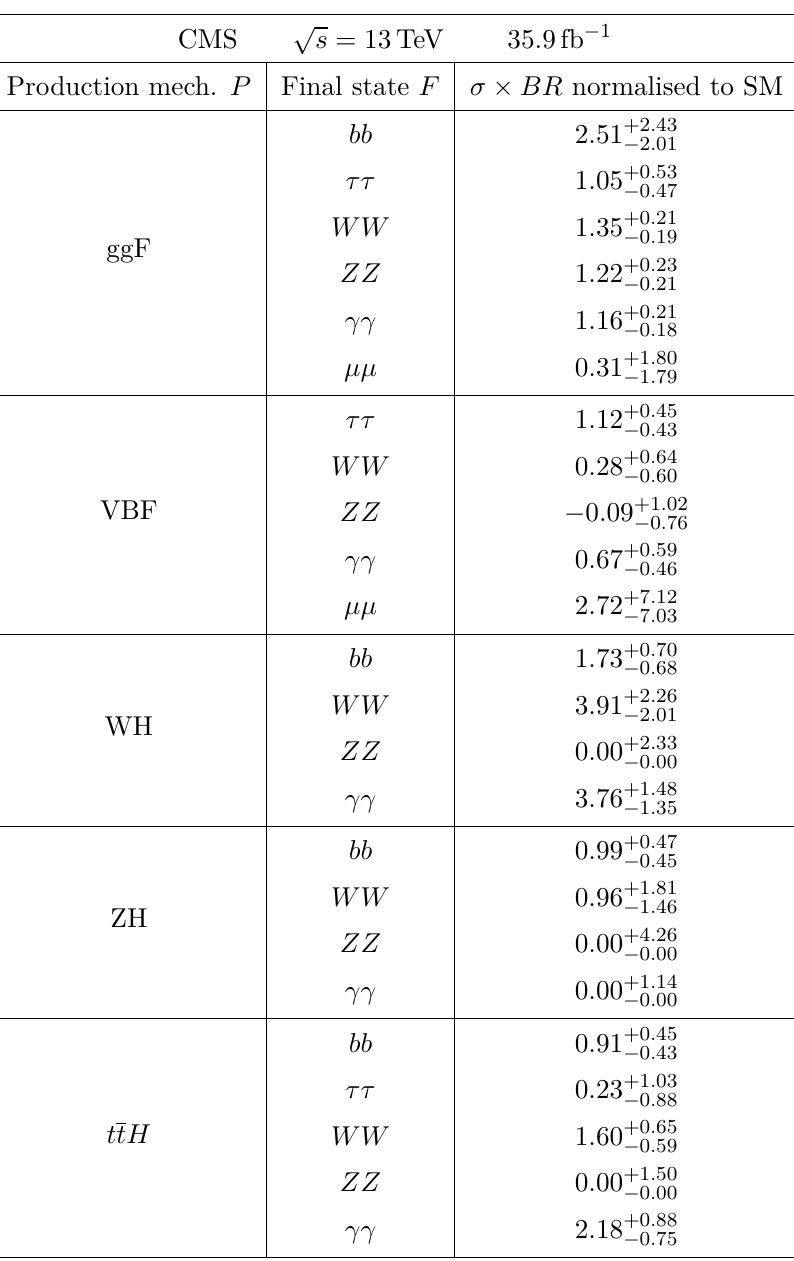
Table 3 . Higgs signal strength from CMS collaboration in ref. [67]. ggF stands for gluon fusion, VBF for vector boson fusion, ZH and WH for Z- and W-Higgs boson associated production, respec- tively, while ttH for associated Higgs boson production with tt